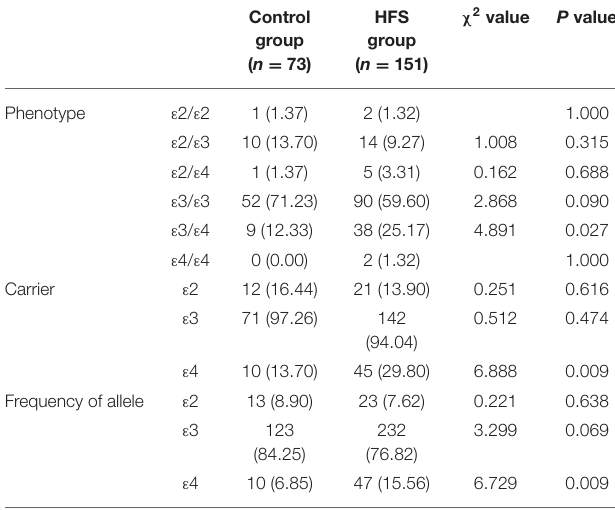
TABLE 3 | Statistics Analysis of the HFS group and the control group ( n ,